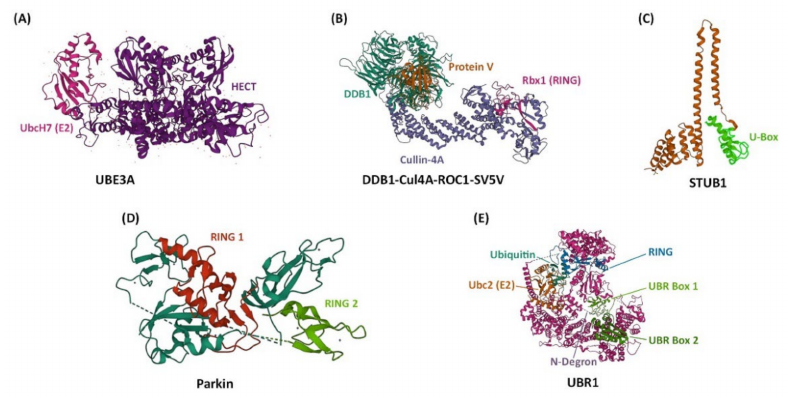
Figure 1. The structures of representative E3 ubiquitin ligases for each structural class. Atomic models were taken from the RCSB protein data bank (PDB, rcsb.org) and images were created using Mol* [20,21]. ( A ) UBE3A from humans, shown attached to the E2-ubiquitin-conjugating enzyme UbcH7. UBE3A is an example of a HECT type E3 ubiquitin ligase (PDB code 1C4Z) [22]. ( B ) DDB1– CUL4A-ROC1 from humans, shown attached to the non-structural V protein of the simian virus 5 (SV5-V). DDB1–CUL4A-ROC1 complex contains Ring-box-1 (Rbx1) and is an example of a RING finger type E3 ubiquitin ligase (PBD code 2HYE) [23]. ( C ) STUB1 from humans, representing a U-box type E3 ubiquitin ligase (PDB code 2C2L) [24]. ( D ) Parkin from brown rat, representing a RING-BetweenRING-RING type E3 ubiquitin ligase (PDB code 4K95) [25]. ( E ) UBR1 from yeast, shown in an initiating complex with ubiquitin, the E2-ubiquitin-conjugating enzyme Ubc2, and an N-Degron (indicated by a dashed line). All UBR proteins contain a UBR box, and UBR1 also contains a RING domain (PDB code 7MEX)